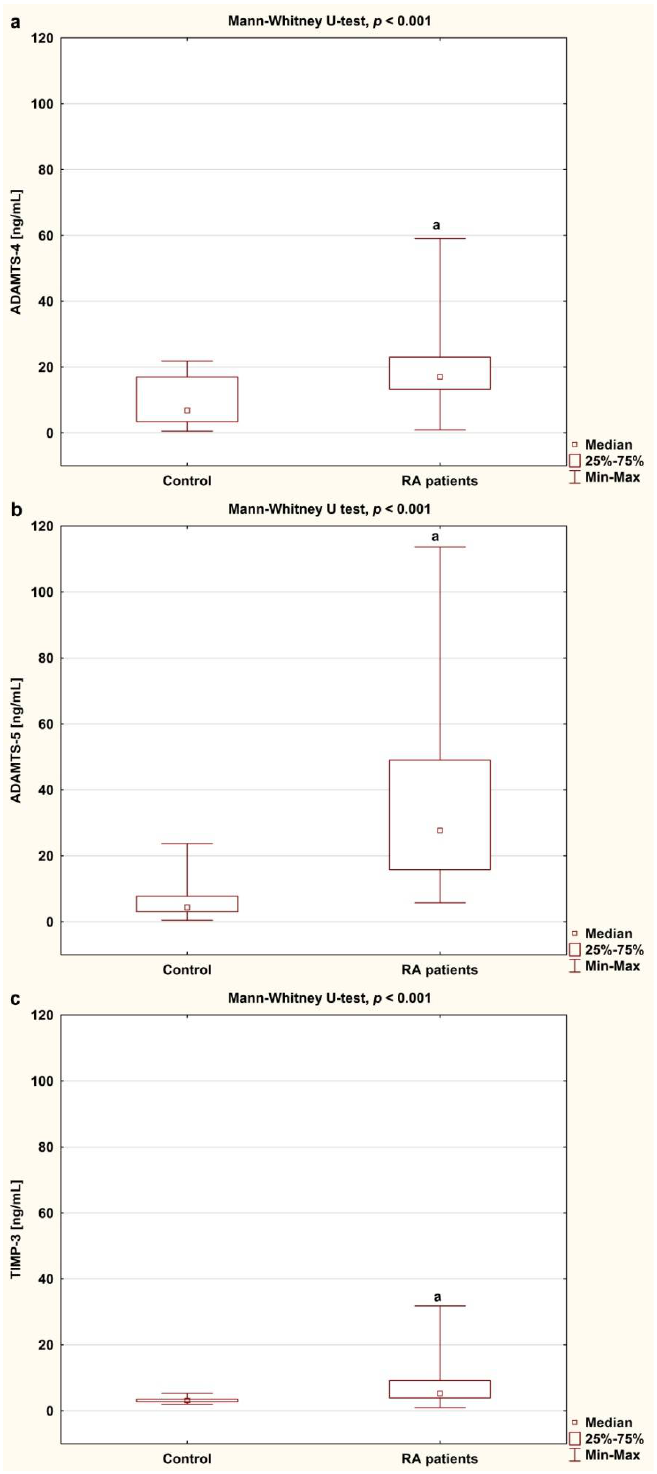
Figure 4. Serum levels of ADAMTS-4 ( a ), ADAMTS-5 ( b ) and TIMP-3 ( c ) in RA patients and in controls. Results expressed as median and interquartile (25th–75th percentile) range. Data analyzed using Mann–Whitney U test. a statistically significant differences compared to controls. ADAMTS-4 and ADAMTS-5, disintegrin and metalloproteinase with thrombospondin motifs 4 and 5; RA, rheumatoid arthritis; TIMP-3, tissue inhibitor of metalloproteinase-3.